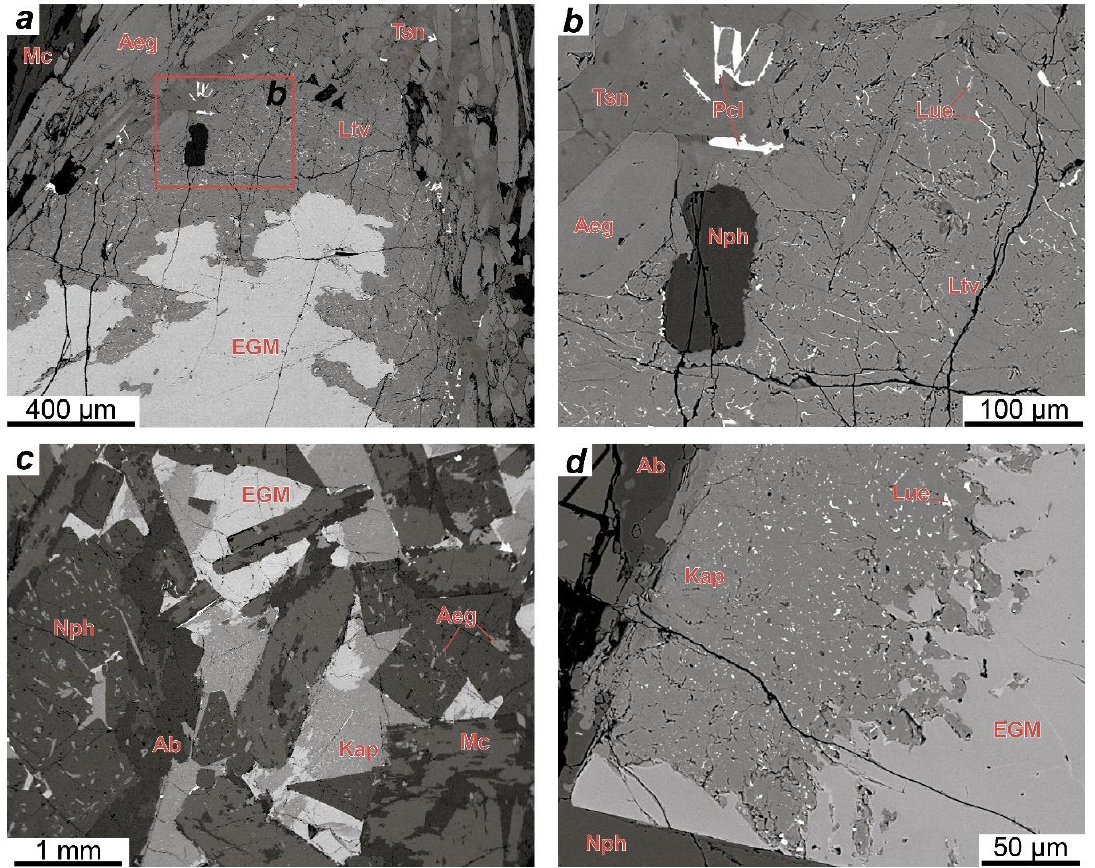
Figure 9. Products of the EGM decomposition. ( a ) lujavrite LV-228-176 (Mt. Alluaiv); ( b ) detailed part of Figure 9a (red rectangle); ( c , d ) foyaite LV-33-32 (Mt. Alluaiv). BSE-images. The composition of the lovozerite-group minerals is shown in Table 5.